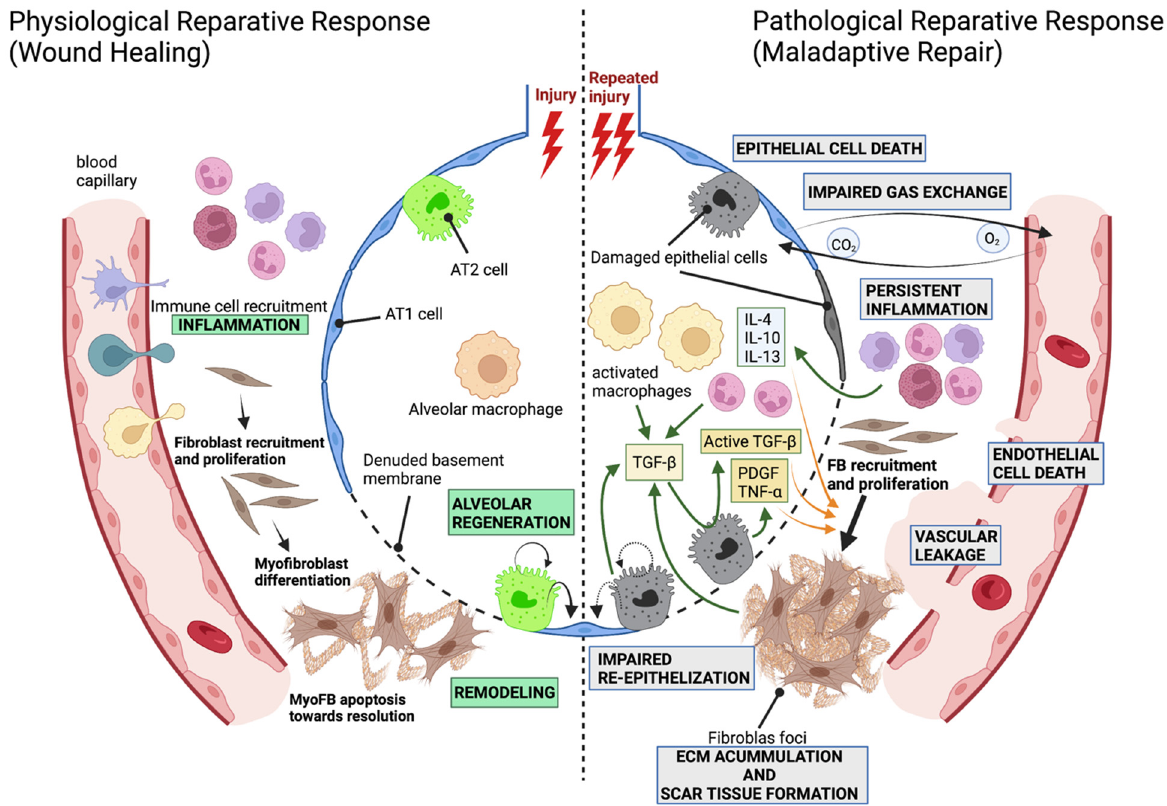
Figure 1. Alveolus under normal and aberrant wound healing. Left: In normal circumstances, after injury in the alveolar epithelium, immune cells are recruited into the lung interstitium and an acute inflammatory response takes place. The cytokines released during inflammation by immune cells together with other factors produced by epithelial and endothelial cells elicit fibroblast proliferation and myofibroblast differentiation. Myofibroblasts (MyoFB) secrete extracellular matrix (ECM) that contributes to tissue remodeling and alveolar type 2 (AT2) cells, that serve as alveolar stem cells in the adult lung, self-renew and give rise to AT1 cells to regenerate the alveolar epithelium. Then, MyoFB are eliminated by apoptosis and homeostasis is restored. Right: Upon repetitive injury, normal wound healing turns into an aberrant response where damaged epithelial cells lose their ability to properly repopulate the alveolar epithelium, myofibroblasts in the fibroblast foci produce excessive amounts of ECM that results in tissue scarring, and vascular leakage takes place after endothelial cell death. As a consequence, gas exchange is impaired. The non-resolved tissue repair includes persistence of inflammation with interstitial immune cell accumulation and alveolar immune cell infiltrates. The release of anti-inflammatory citokines such as IL-4, IL-10 and IL-13 impacts fibroblast recruitment and proliferation and promotes macrophage polarization into alternatively activated macrophages. These macrophages, neutrophils, myofibroblasts and AT2 cells produce TGF- β , a major player involved in this process, that together with platelet-derived growth factor (PDGF) and tumor necrosis factor alfa (TNF- α ) produced by AT2 cells, contribute to fibroblast recruitment, proliferation and differentiation. This creates a fibrotic loop that contributes to disease progression in IPF (Image created with BioRender).